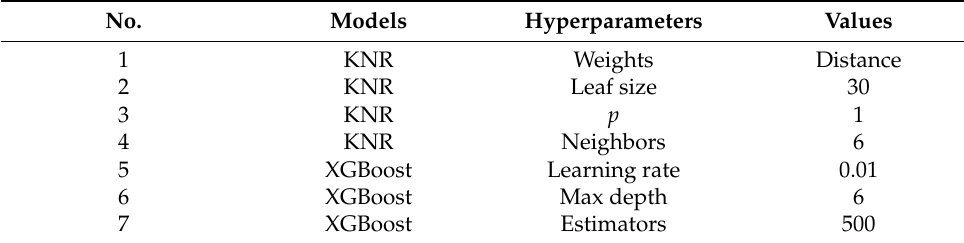
Table 4. Hyperparameters of KNR and XGBoost